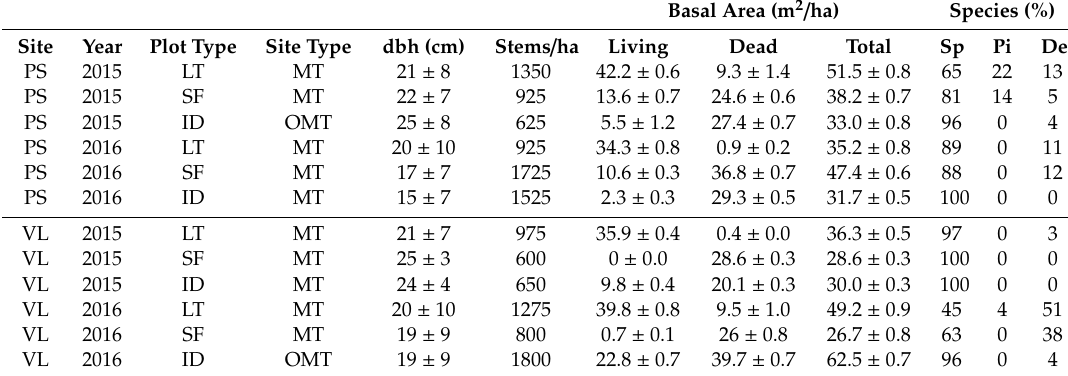
Table 1. Study plot disturbance and stand characteristics (mean ± standard deviation). Abbreviations: Year = year of plot establishment, dbh = tree diameter at breast height, Stems / ha = number of trees per hectare, Basal area = basal area of trees, Species (%) = percentage of basal area of certain tree species from all measured trees on plot, Sp = spruce, Pi = pine, De = deciduous, PS = Paajasensalo, VL = Viitalampi, LT = living trees, ID = trees killed by I. typographus , SF = storm-felled trees, MT = medium-rich Myrtillus type, OMT = Oxalis-Myrtillus type.